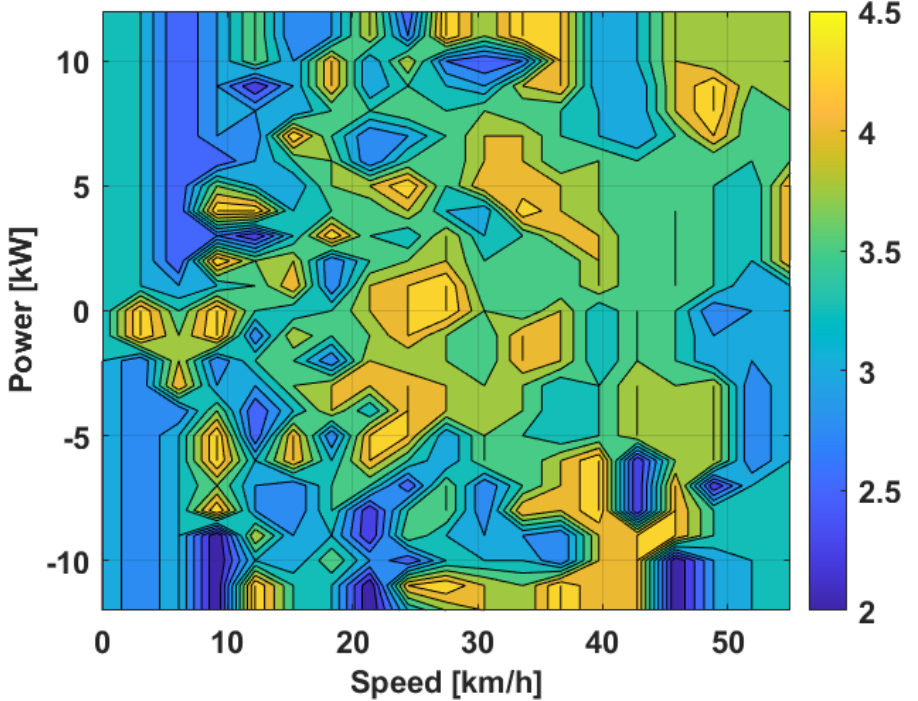
Figure 2. High-resolution matrix for transmission ratio evaluation.